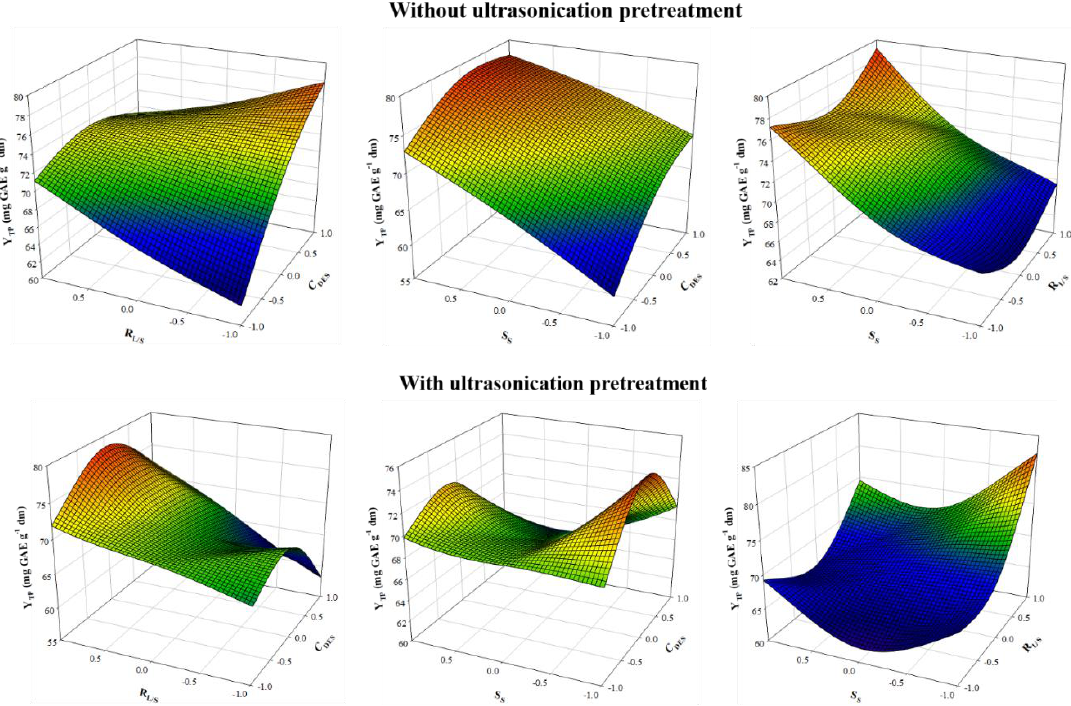
Figure 4. Three-dimensional diagrams given on a comparative arrangement, to illustrate the effect of ultrasonication pretreatment on the variations in the response (Y TP ), as a function of different variable levels.